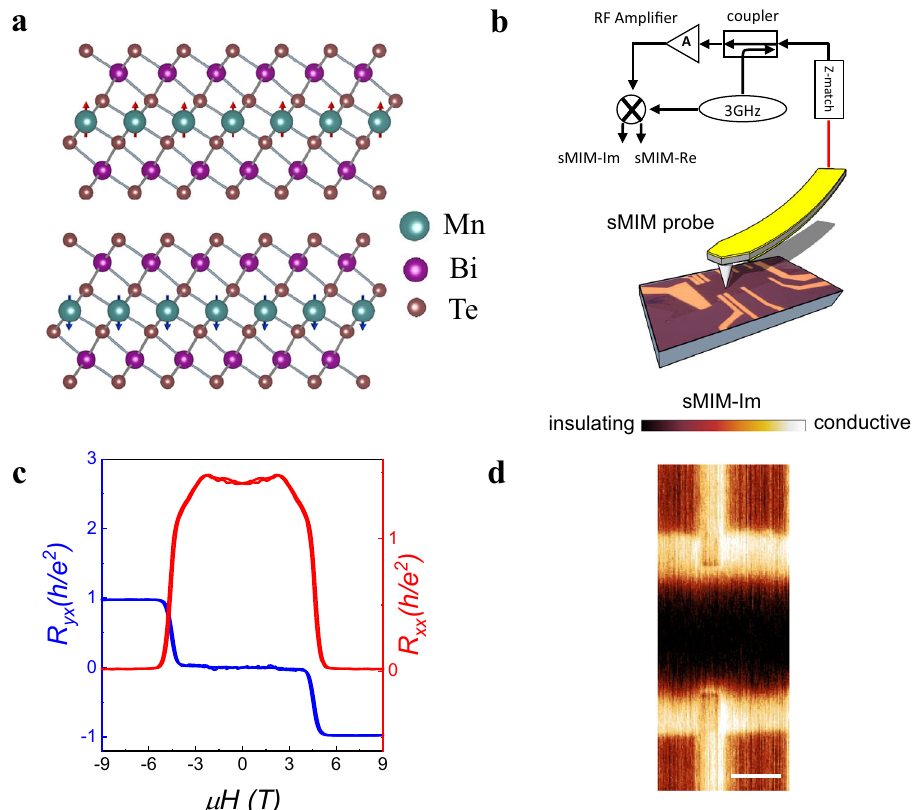
Fig. 1 | Experimental set-up and transport characterization of the 6-SL MnBi 2 Te 4 device. a Crystal and magnetic structure of MnBi 2 Te 4 . b Schematic diagram of scanning Microwave Impedance Microscopy (sMIM). c Magnetic fi eld